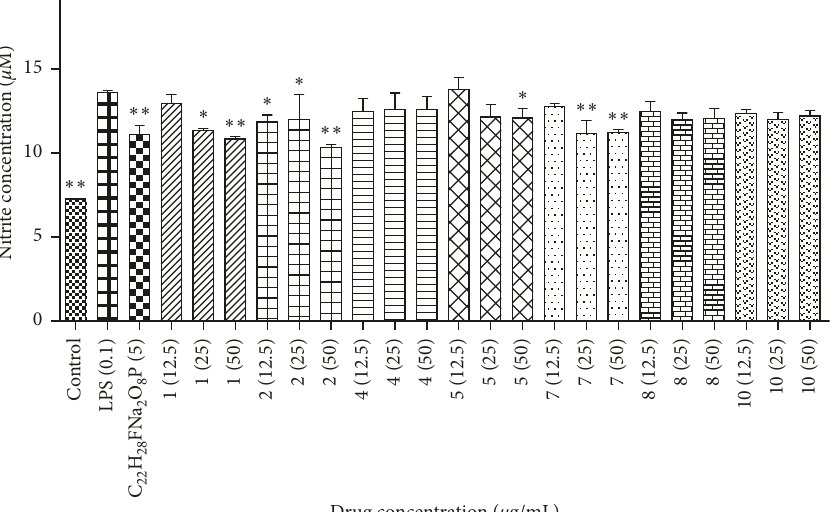
Figure 5: Anti-inflammatory effects of the isolated compounds and inhibition of LPS-induced NO production in RAW 264.7 mouse macrophages. The cells were pretreated with concentrations (12.5, 25, and 50 μ g/mL) of compounds ( 1 , 2 , 4 , 5 , 7 , 8 , and 10 ) or C 22 H 28 FNa 2 O 8 P (5 μ g/mL) for 1h and then stimulated with LPS (0.1 μ g/mL) for 16h. The data show the mean p p experiments performed in triplicates. 0 . 05 and 0 . 01 compared to the LPS-treated values. Arillatanoside E ( 1 ), oleanolic acid ( 2 ), trans -ferulic acid ( 4 ), trans -feruloyl-glucoside ( 5 ), 2,4,6-trimethoxy-1- O - β -D-glycoside ( 7 ), 3-methoxy-4-hydroxybenzoic acid ( 8 ), and ∗ ∗∗ sinapic acid ( 10 < <